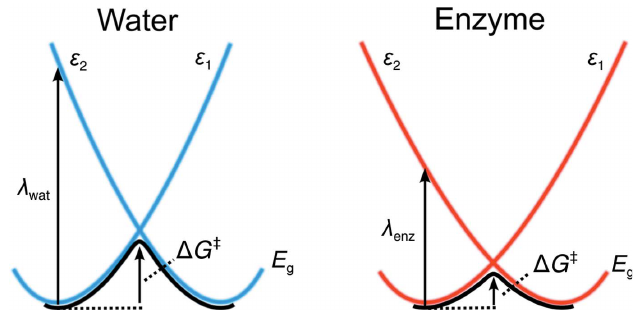
Figure 2 Schematic representation of the relationship between the different EVB diabatic states ( " 1 and " 2 ) in a simple two-state reaction, the corresponding adiabatic reorganization energy ( (cid:6) ) and the resulting activation barriers ( (cid:2) G ‡ ) in water (left) and in an enzyme (right). Both (cid:6) and (cid:2) G ‡ are significantly smaller in the enzyme, i.e. the enzyme would be a catalyst for this hypothetical reaction (Warshel et al. ,